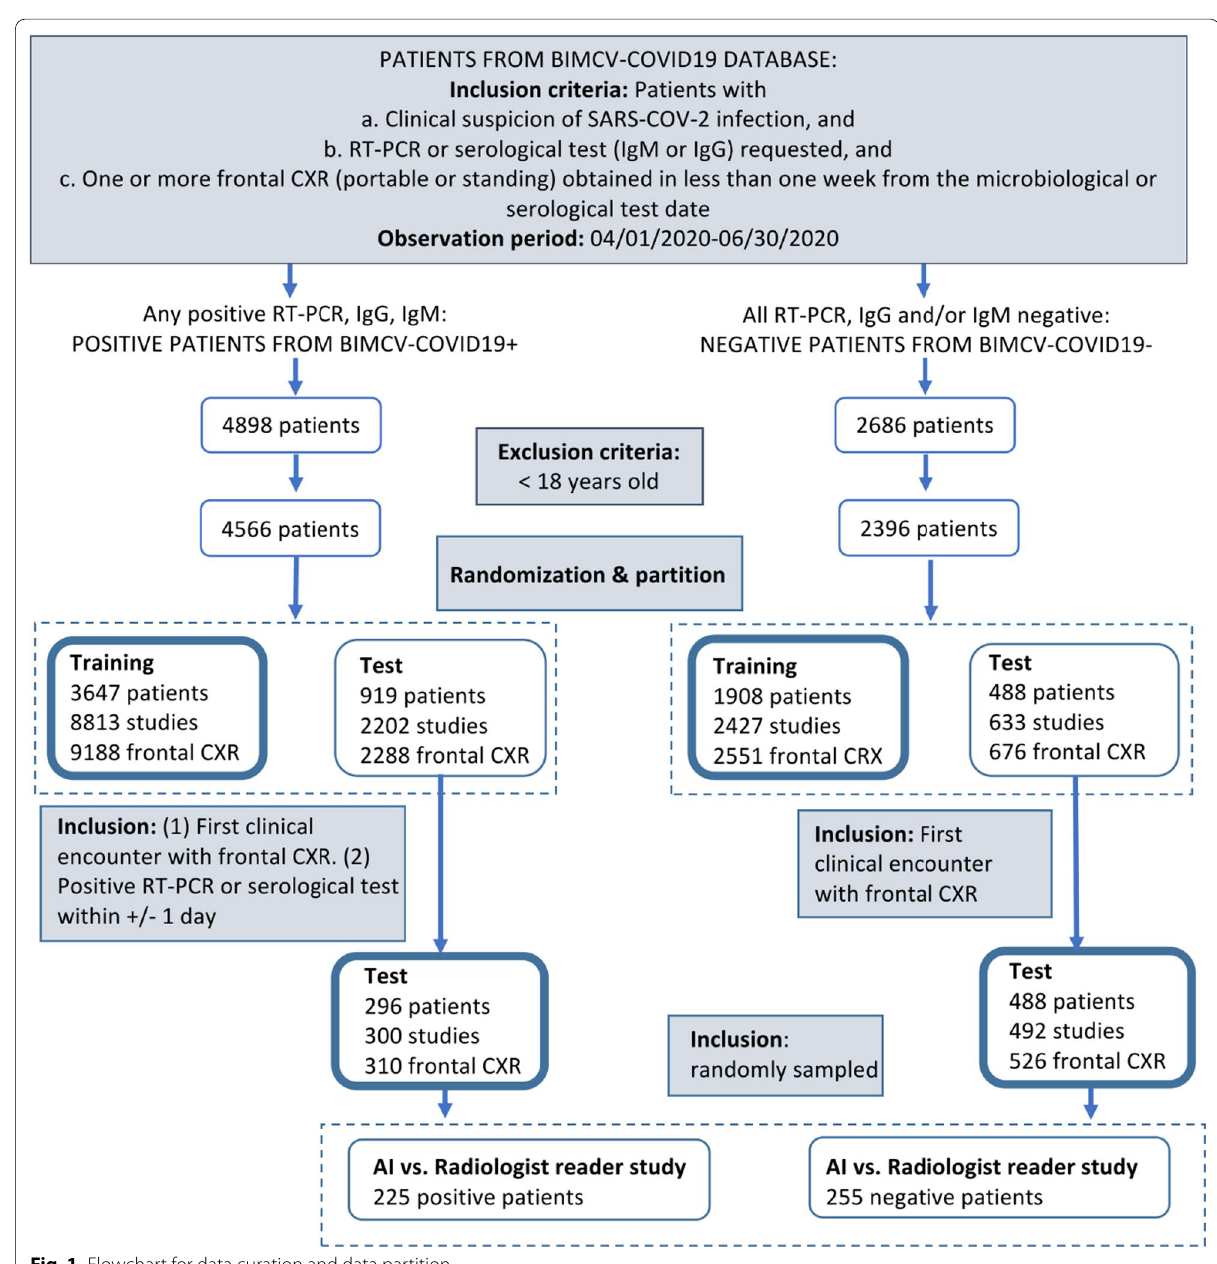
Fig. 1 Flowchart for data curation and data